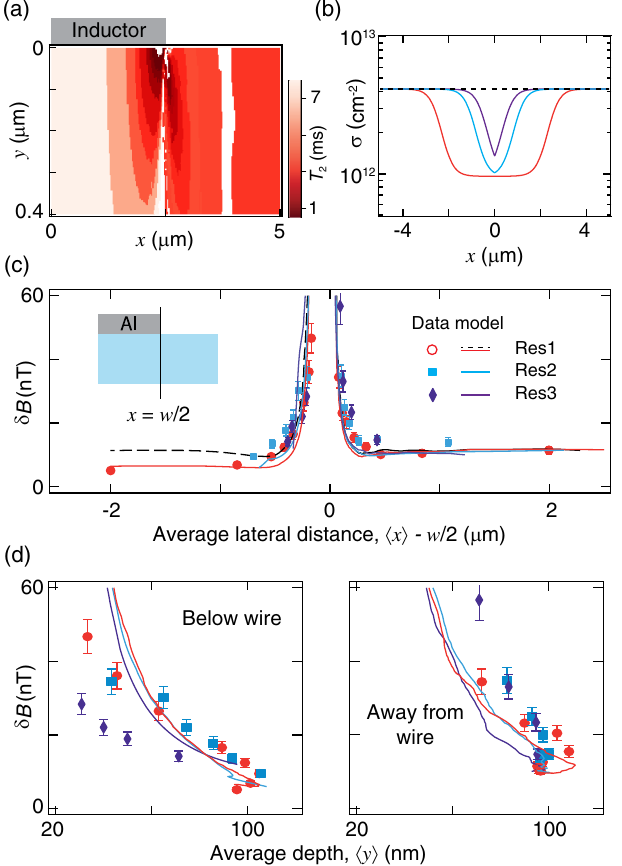
FIG. 5. Spatially dependent magnetic noise. (a) Measured coherence time T 2 of the first transition ( i ¼ 1 ) versus the inferred spin locations from A ð B 0 Þ in Res1. (b) Reconstructed surface magnetic impurity distribution σ as a function of the position x with respect to the wire center for the three resonators. (c,d) Magnetic noise magnitude for the three different resonators as a function of the average spin position inferred from A ð B 0 Þ and the implantation profile. Measurements are colored symbols, and the model described in the text is shown by solid lines. The dashed black curve in panel (c) is computed for Res1 assuming a uniform density σ ¼ 4 × 10 12 cm − 2